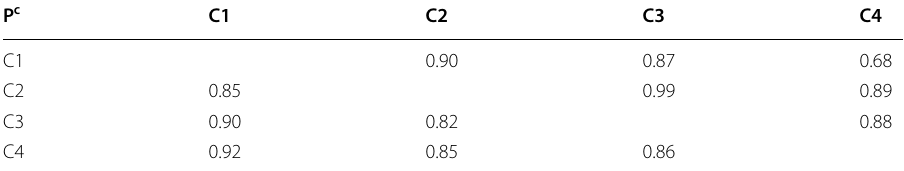
Table 9 Collective fuzzy preference relations for the equity-based crowdfunding alternative P